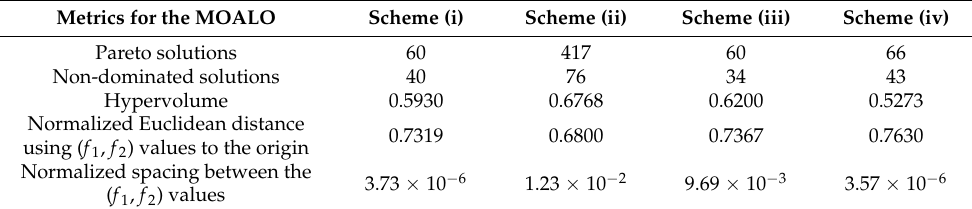
Table 3. Performance metrics for MOALO with four selection schemes (30